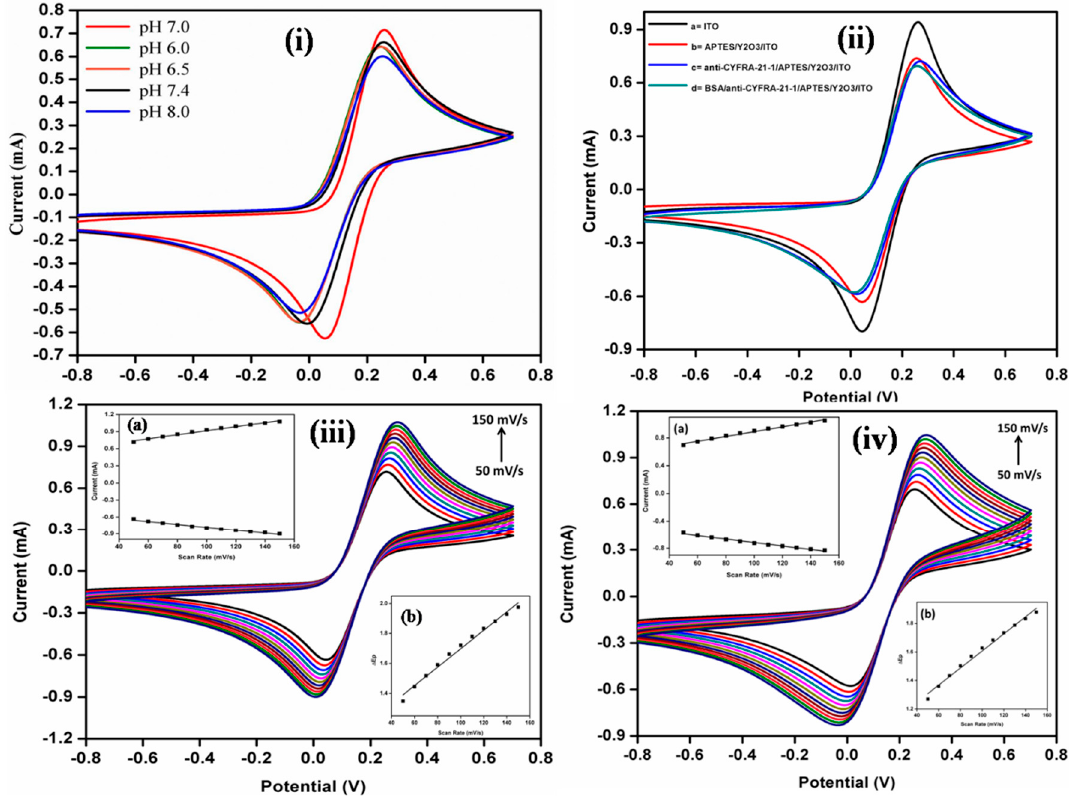
Figure 5. ( i ) CV studies of the BSA / anti-CYFRA-21-1 / APTES / nY 2 O 3 / ITO immunoelectrode on di ff erent pH of [Fe(CN) 6 ] 3 − / 4 − containing PBS; ( ii ) electrochemical response of the di ff erent electrodes; ( iii ) CV response of APTES / nY 2 O 3 / ITO electrode; and ( iv ) the BSA / anti-CYFRA-21-1 / APTES / nY 2 O 3 / ITO immunoelectrode as a function of scan rate (50–150 mV / s). In both images, inset ( a ) magnitude of anodic (I pa ) and cathodic (I pc ) peak current as a function of scan rate (mV / s), and inset ( b ) di ff erence potential ∆ E p = E pa − E pc as a function of scan rate.